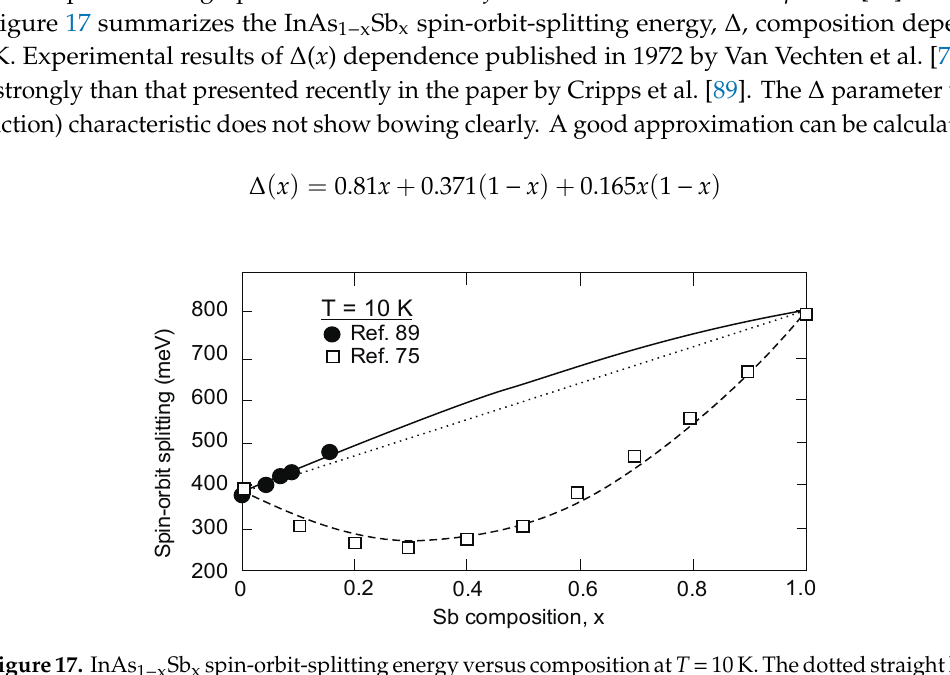
Figure 17. InAs 1–x Sb x spin-orbit-splitting energy versus composition at T = 10 K. The dotted straight line represents the zero bowing behavior consistent with the VCA. The single points represent experimental data [75,89].